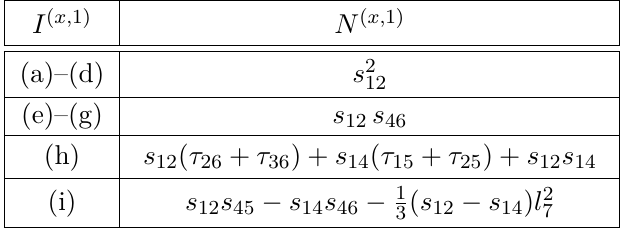
Table 1 . N = 4 SYM numerator factors (from ref.